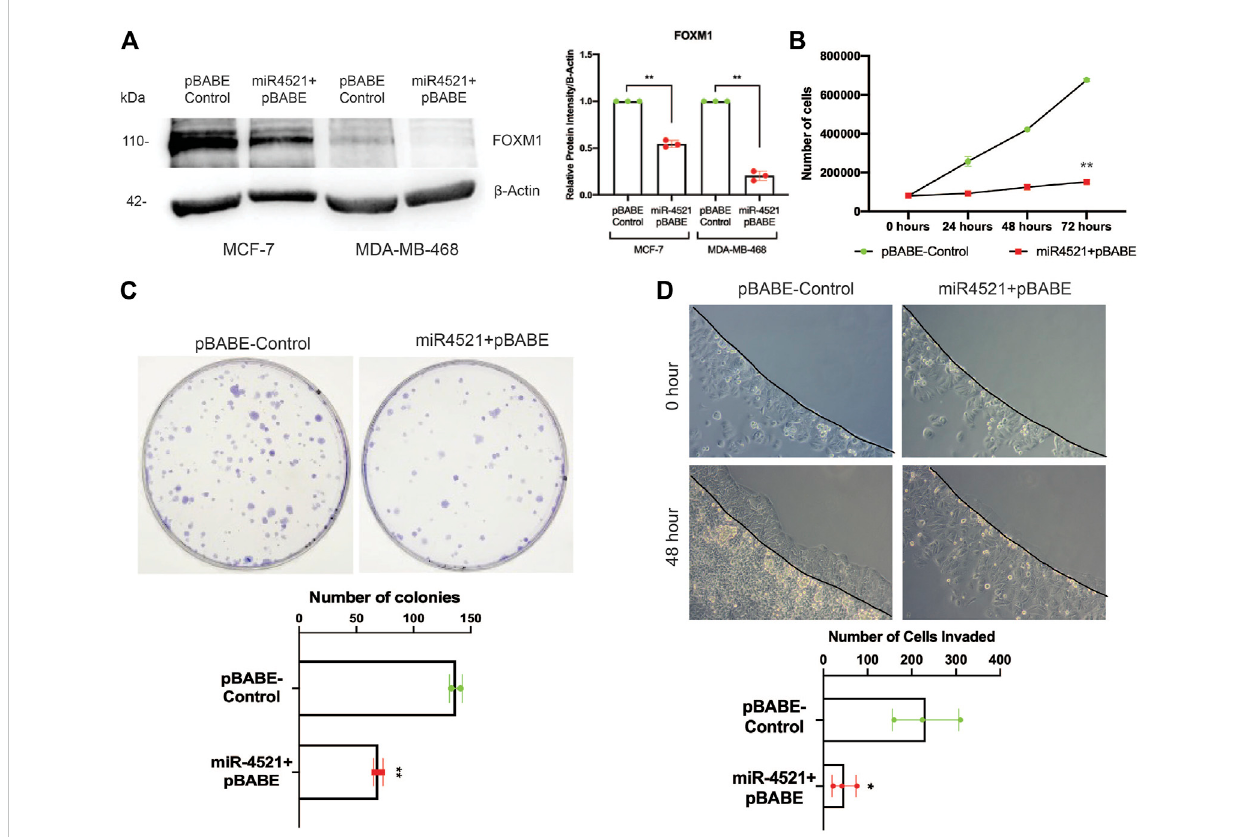
FIGURE 3 miR-4521 expression perturbs breast cancer cell proliferation, tumor growth, and invasion by downregulating FOXM1 expression. (A) Western blot analysis of FOXM1 protein levels in MCF-7 and MDA-MB-468 breast cancer cells stably expressing miR-4521. β -Actin wasused as loading control; paired Student ’ s t -test (two-tailed) was performed between control and miR-4521 over expressing groups, ** p < 0.001, ( n = 3). (B) Proliferation rate of MCF-7 cells upon miR-4521 overexpression compared to control cells; paired Student ’ s t -test (two-tailed) was performed between control and miR-4521 over expressing groups, ** p < 0.001, ( n = 3). (C) Colony formation assay among MCF-7 cells expressing miR-4521 and control cells was performed for 14 days, paired Student ’ s t -test (two-tailed) ** p < 0.001, ( n = 3); (D) Invasion assay upon miR-4521 over expression in MCF-7 cell lines using 0.5% low- melting agarose spots with 50 ng/mL EGF for 48 h. Quanti fi cation was performed by counting the number of agarose spot invaded cells from 3different ROI; paired Student ’ s t -test (two-tailed) was performed between control and miR-4521 over expression groups, * p < 0.05, ( n =